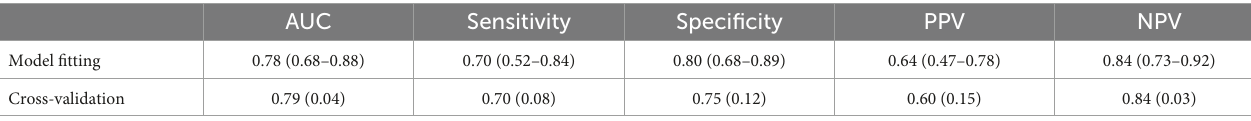
TABLE 4 Model discrimination metrics for model fitting and internal validation with